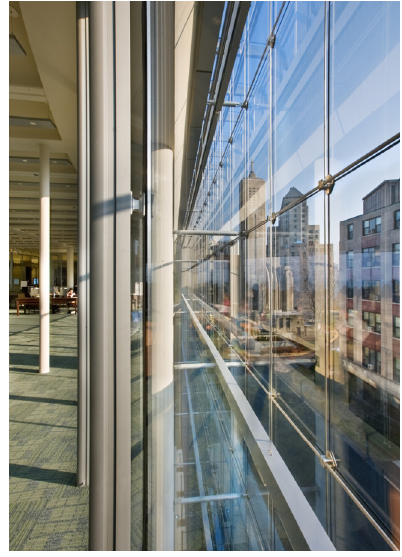
Figure 7. Transsolar Double Skin Façade—Loyola Info Commons, Reprinted with Permission from © 2008, James Steinkamp, Steinkamp Photography, © Solomon Cordwell